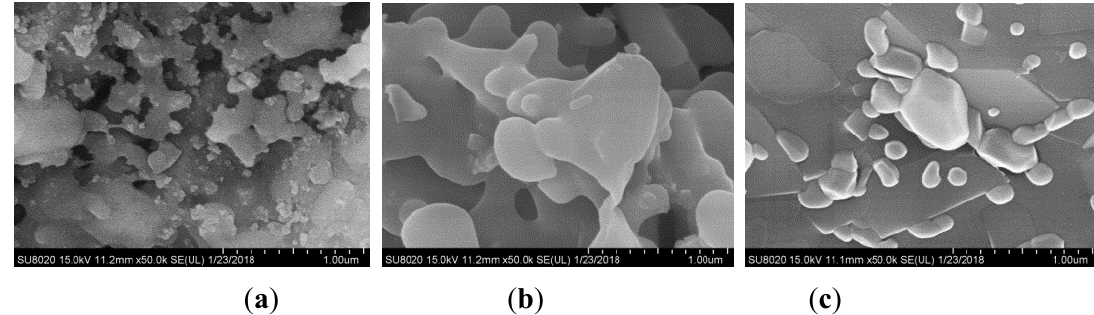
Figure 2. SEM images of ash samples: ( a ) WS ash produced at 800 °C; ( b ) WS ash produced at 1000 ◦ C at 50,000 magnification. °C; ( c ) ash produced in co-combustion at 1000 °C at 50,000 magnification. ( c ) ash produced in co-combustion at 1000